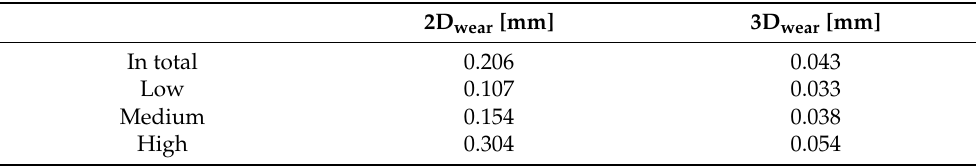
Table 1. Precision (SD) of overall and individual wear groups in 2D wear and 3D wear .